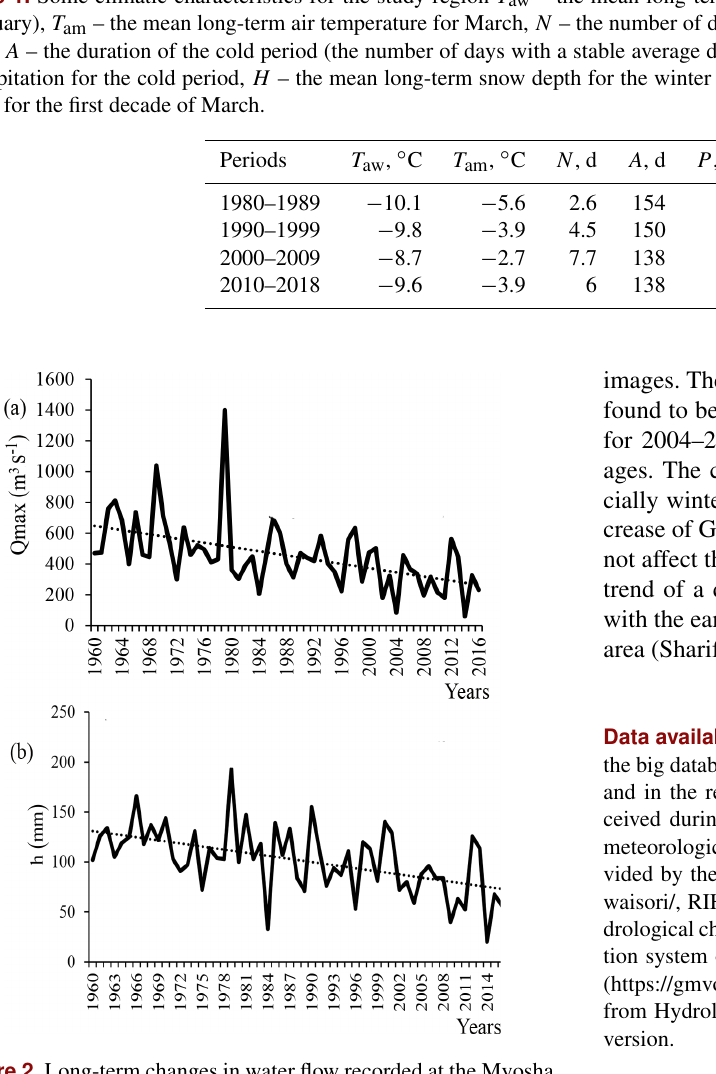
Figure 2. Long-term changes in water flow recorded at the Myosha River, (a) maximum annual water discharges (during the spring snowmelt period), (b) water runoff depth in the basin during the spring flood